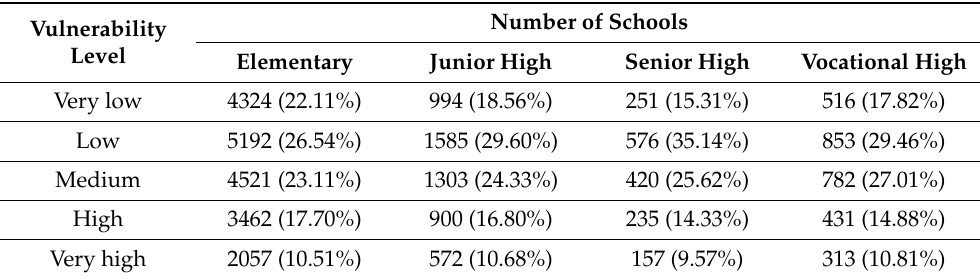
Table 3. The number of schools at each level of disaster vulnerability.